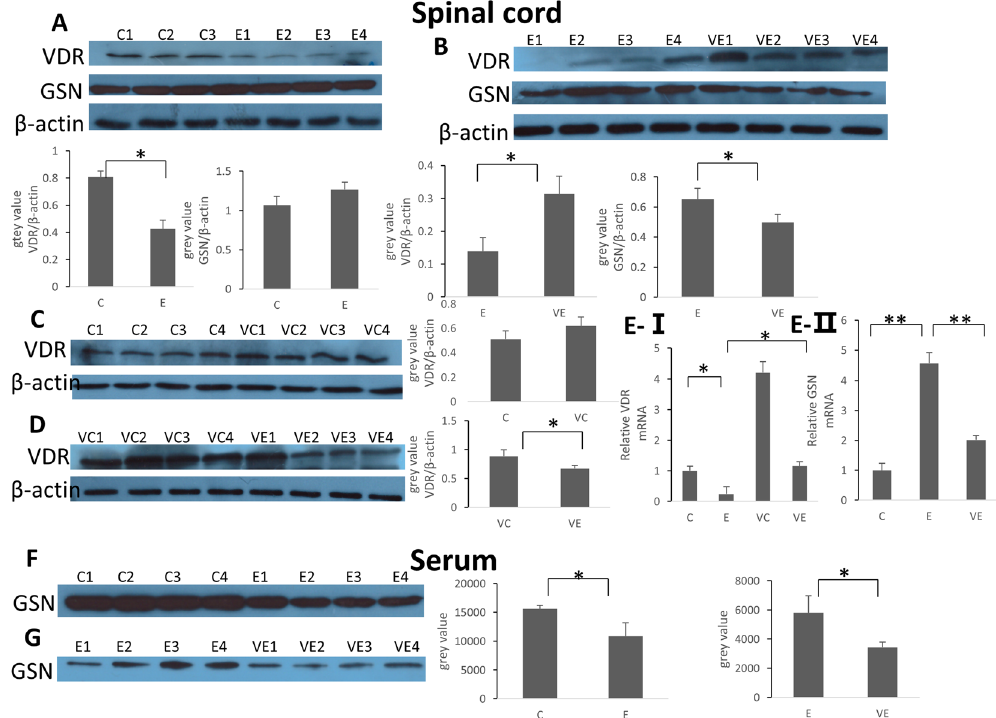
Figure 4. The changes of VDR and GSN levels after EAE induction or vitamin D supplementation. ( A ) Western blotting of VDR and cGSN in the spinal cord of the control and EAE rat groups. ( B ) Western blotting was performed to compare the levels of VDR and cGSN in the spinal cords of group E rats (E1–4) to the levels in group VE rats (VE1–4). ( C ) Western blotting of VDR in the spinal cords of the control rats without (C1–C4) with (VC1–VC4) vitamin D supplementation. ( D ) Western blotting of VDR in the spinal cords of rats with vitamin D supplementation with or without EAE induction. ( E ) Real-time PCR of VDR or GSN mRNA levels in the spinal cords of rats from each group. Results (means + SD of triplicates) are representative of 3 independent experiments. ( F ) Western blotting analysis of the levels of pGSN in the serum of the control rats (C1–4) compared to the levels in the EAE rats (E1–4). We calculated the relative volume percentage of each band using Quantity One software. * p < 0.05 (one-way ANOVA). ( G ) Western blotting comparison of pGSN in the serum of EAE rats with EAE (E1–4) fed vitamin D supplements (VE1–4). We calculated the relative volume percentage of each band using Quantity One software. * p < 0.05 (one-way